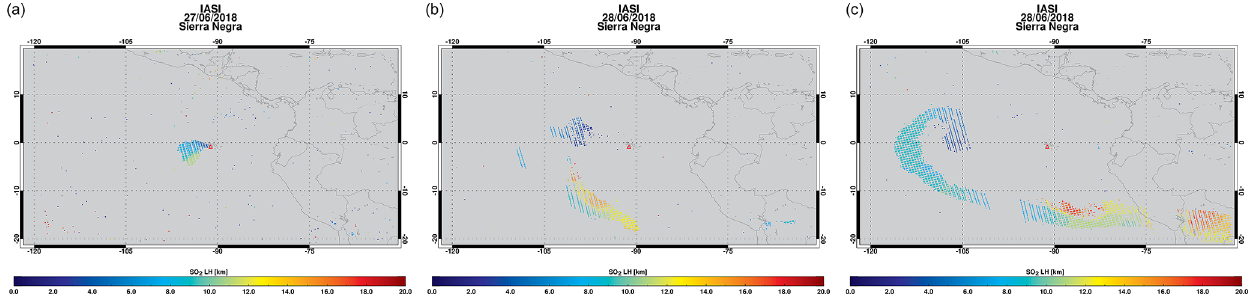
Figure 12. MetOp-A and -B IASI SO 2 LH results for the Sierra Negra SO 2 plume from 27 (a) to 29 June 2018 (b) with overpass times of around 02:00 – about 6h after the TROPOMI